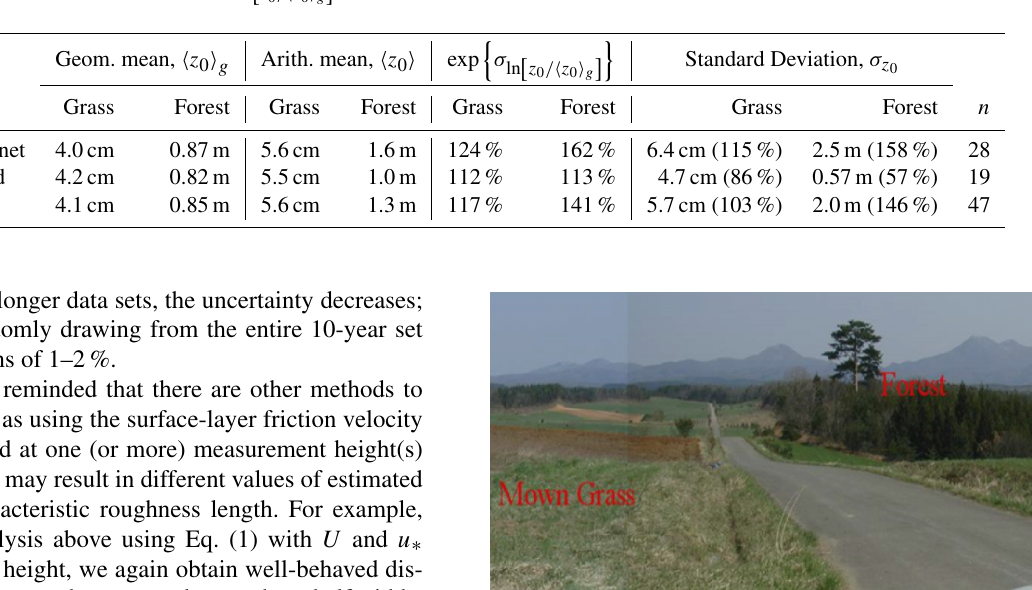
/ (cid:104) z 0 (cid:105) , given for comparison , number in parenthesis is σ z 0 0 } ). ln (cid:2) z 0 / (cid:104) z 0 (cid:105) g (cid:3)